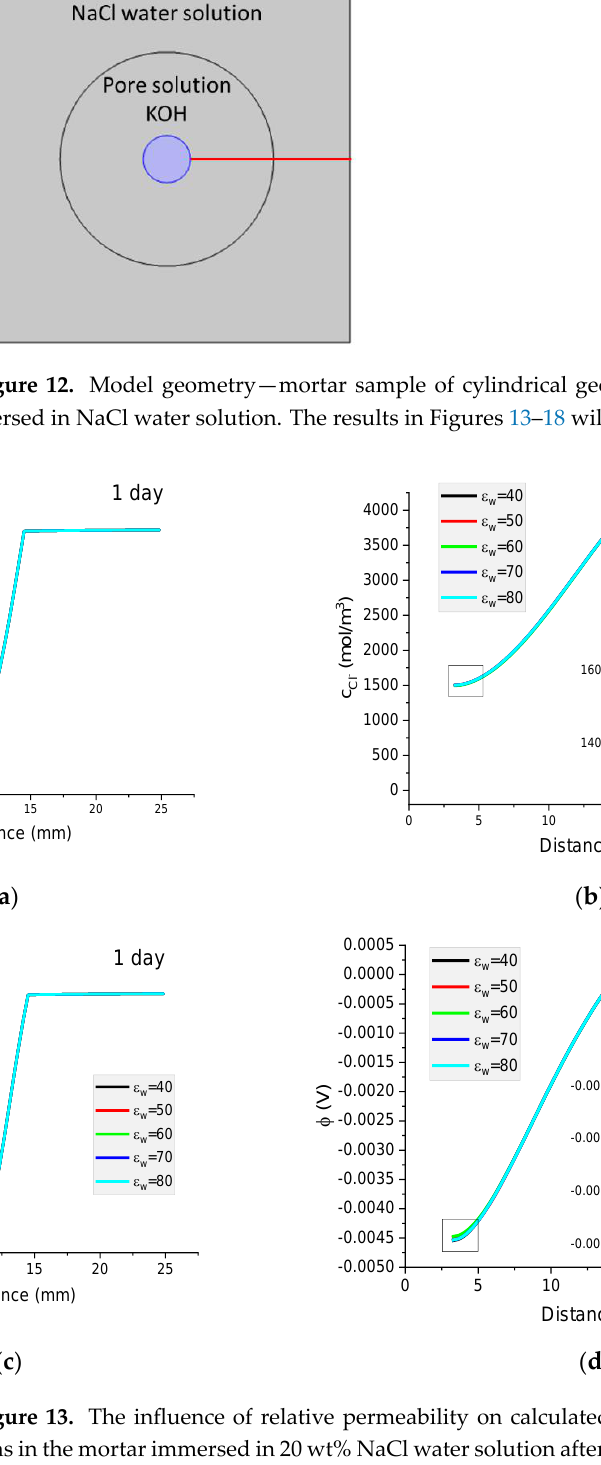
Figure 12. Model geometry — mortar sample of cylindrical geometry with an iron rod inside im- mersed in NaCl water solution. The results in Figures 13 – 18 will be presented along the red line.